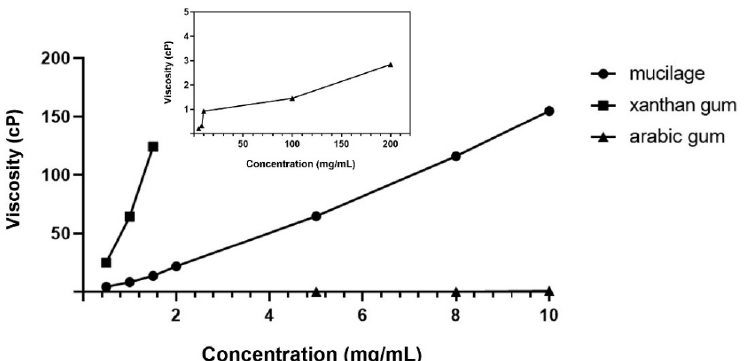
Figure 3. Viscosity of the mucilage from the Corchorus olitorius L., xanthan gum, and arabic gum at different concentrations. The inset represents the viscosity of the arabic gum at concentration of 5, 8, 10, 100, and 200 mg/mL.